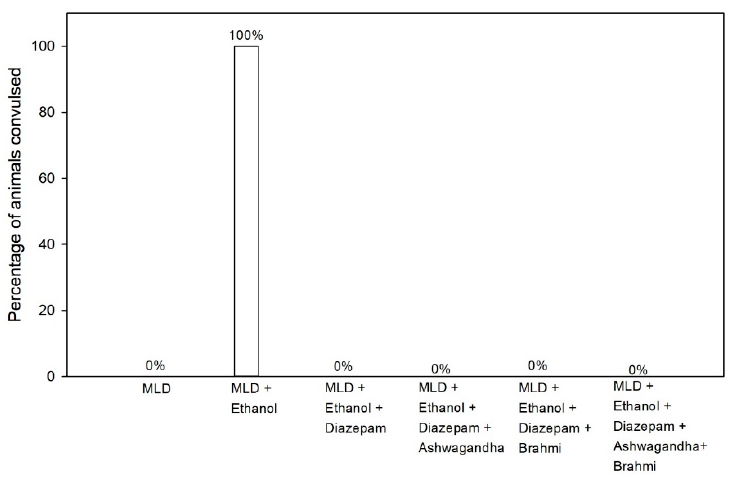
Figure 6. Effect of test drugs on seizures activity represented by the percentage of animals convulsed at 6th hour of alcohol withdrawal after Pentylenetetrazol kindling.